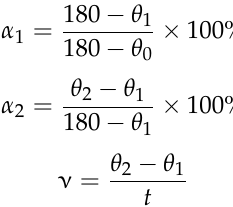
Figure 7. The deformation recovery process of the sample .